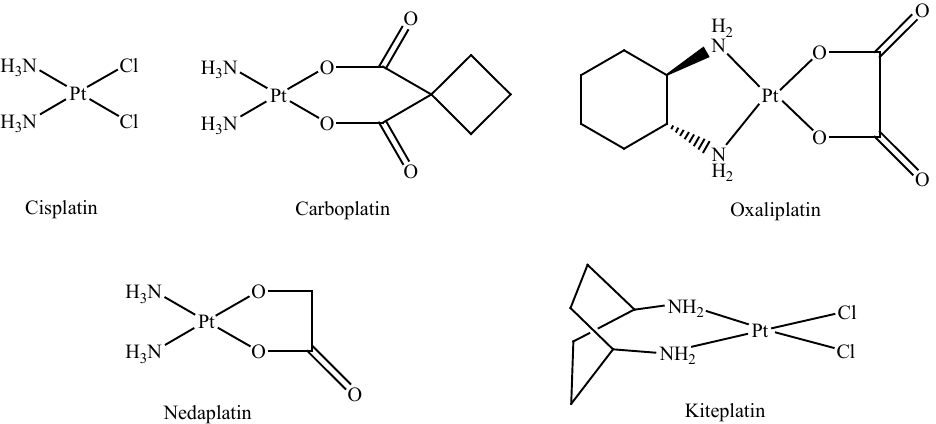
Figure 1. Sketches of clinically used platinum(II) drugs (Cisplatin, Carboplatin, and Oxaliplatin) and of Nedaplatin and Kiteplatin.